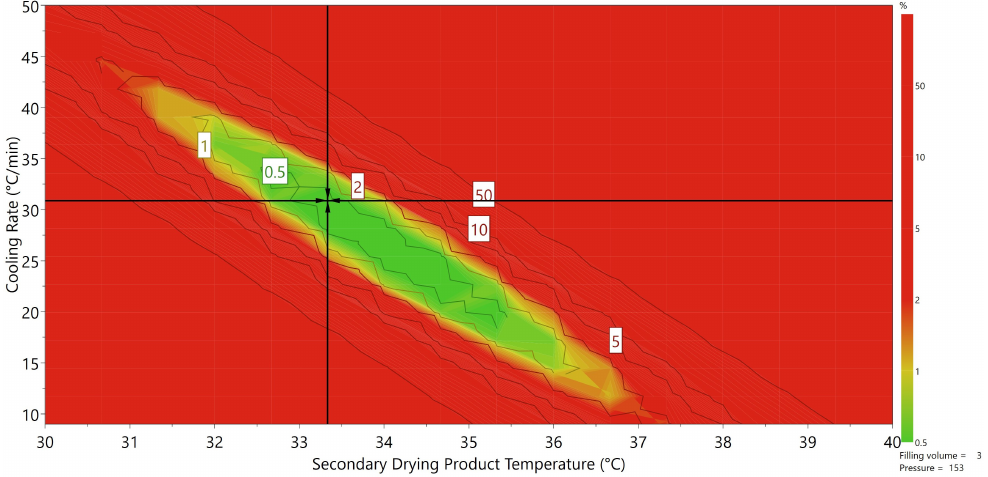
Figure 6. Design space for the significant process settings cooling rate and product temperature. All combinations of process settings in the green area result in a final moisture content between 0.8% and 1.2% with an acceptance value of 1% (filling volume = 3 mL, chamber pressure 15.3 Pa). Red regions indicate combination of process settings, which will lead to acceptance values higher than 1%; the most robust setpoint is indicated by the black arrow